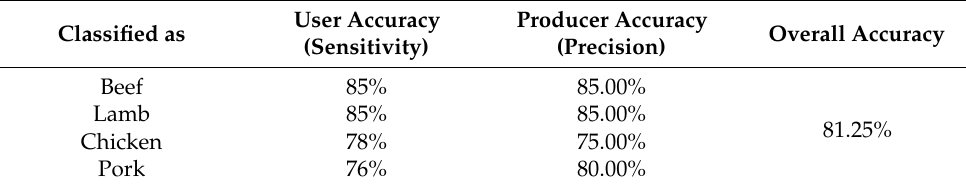
Figure 6. ( a ) Pure samples of all the species using a one-dimensional projection for first principal component. ( b , c ) Principal component analysis of the two and three-dimensional projections of adulterated samples of pork ( * ), chicken ( × ), lamb ( + ), and beef (O), showing the clustering. Table 7. Sensitivity, precision, and classification accuracy for pure samples of beef, lamb, chicken, and pork.